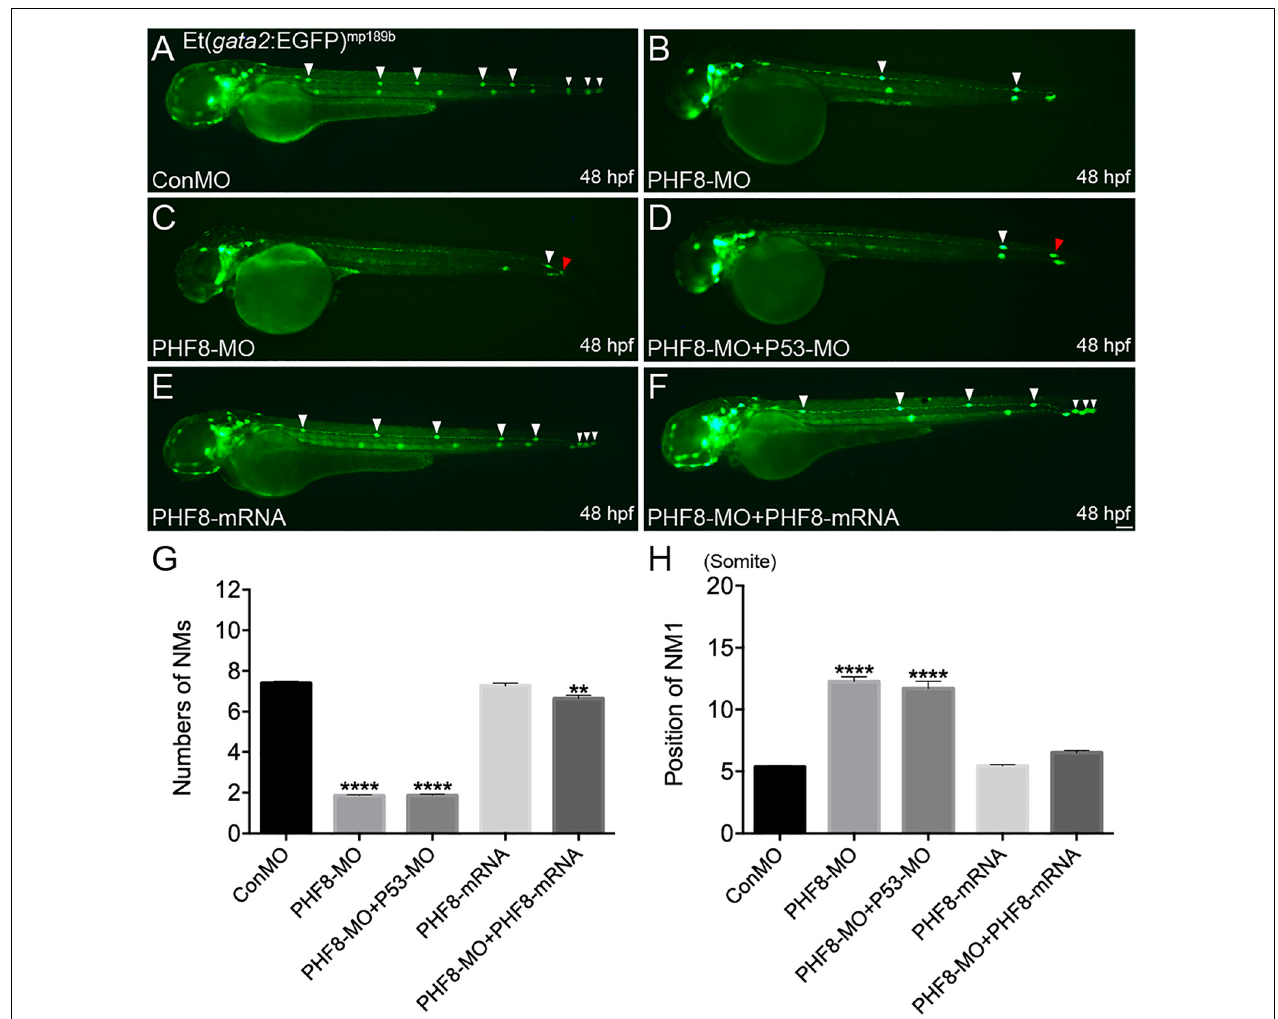
FIGURE 2 | Abnormal PLL neuromast deposition in the PHF8 deficient embryos. (A–F) Optical appearance of fluorescence of 48 hpf larvae expressing Et( gata2 :EGFP) mp189b . (A) The standard control MO (ConMO)-injected embryo illustrates a completed PLL mode. (B–C) PHF8-deficient embryos demonstrate a decrease in deposited neuromasts. (D) The embryo co-injected with PHF8-MO and p53-MO. (E) The embryo is injected with PHF8-mRNA. (F) The embryo co-injected with PHF8-MO and PHF8-mRNA. White arrowheads implicate the positions of the neuromasts on one side, Red arrowhead implicates the location of PLL primordium. (G,H) The quantity of PLL neuromasts (G) and the position of the first neuromast (NM1; H ) were measured. Control embryos (ConMO; n = 112 embryos), PHF8 morphants (PHF8-MO; n = 319 embryos), PHF8-MO co-injected with P53-MO embryos (PHF8-MO + P53-MO; n = 115 embryos), PHF8 embryos injected with mRNA (PHF8-mRNA; n = 76 embryos), and PHF8-MO co-injected with PHF8-mRNA embryos (PHF8-MO + PHF8-mRNA; n = 80 embryos). ** p < 0.01,**** p < 0.0001 vs. the ConMO group. Data are presented as means ± SEM. All pictures showed lateral view, anterior left. Scale bars, 100 µ m. Neuromast,